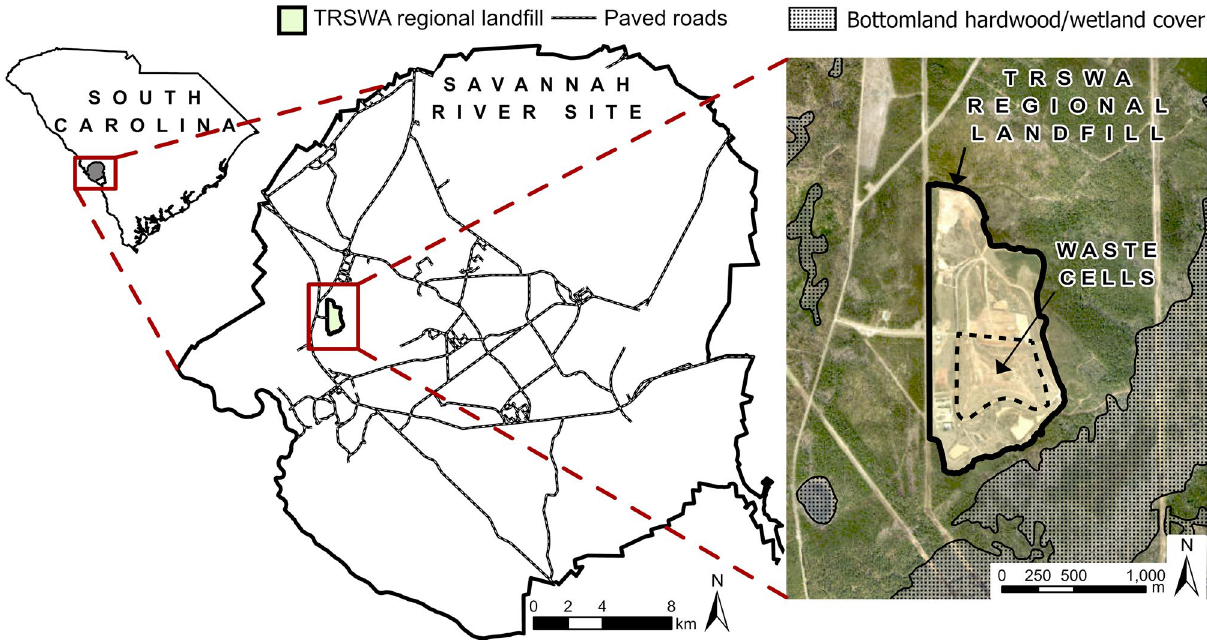
Figure 1. Location of the Three Rivers Solid Waste Authority (TRSWA) regional landfill and waste cells on the Savannah River Site, South Carolina, USA. Map created using ArcGIS Pro version 2.8.1 (https:// www. esri. com) 17